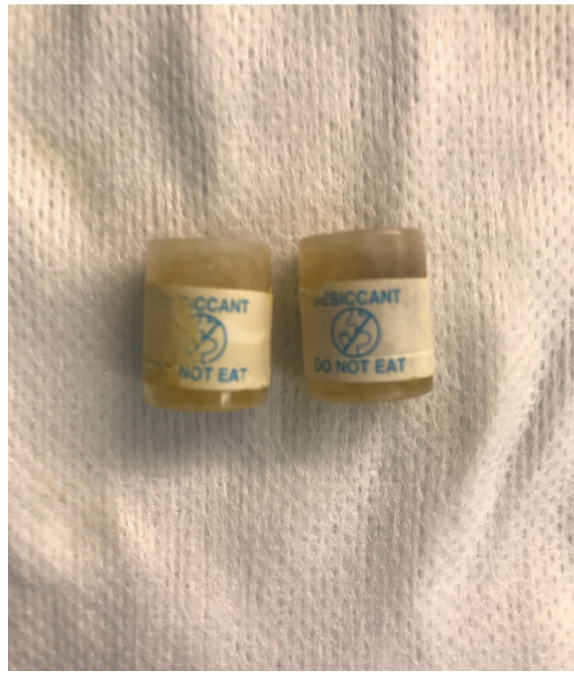
Figure 4: Desiccant canisters after